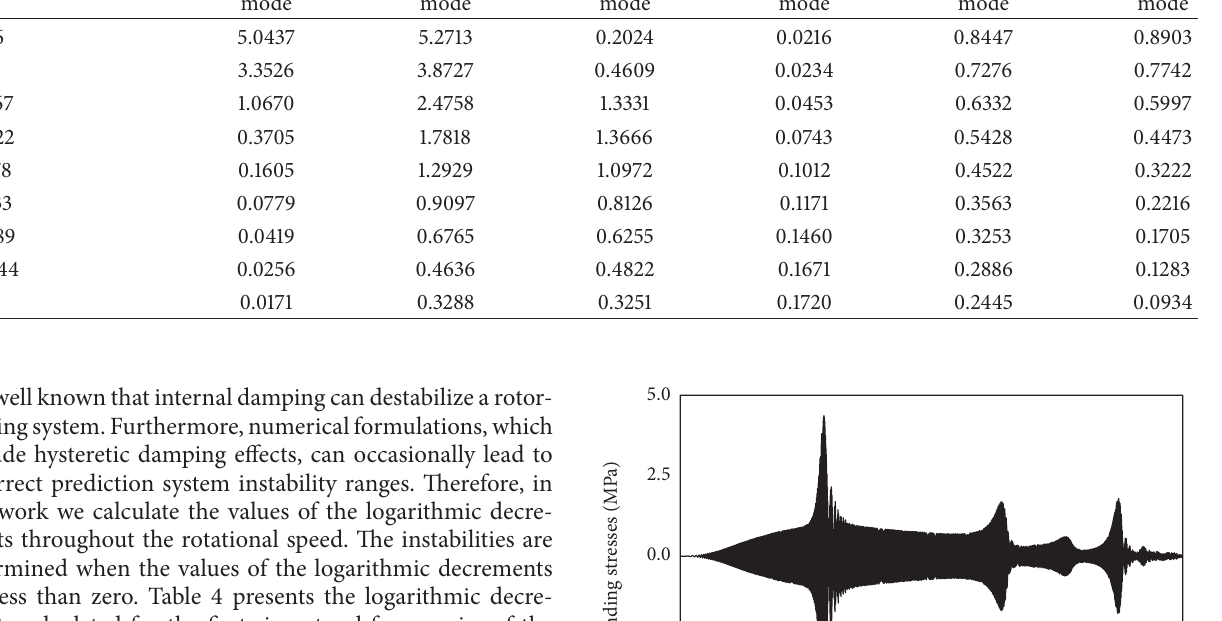
Table 4: Logarithmic decrements calculated for the six first natural frequencies of the rotor-bearing system. Rotational speed [ Hz ]